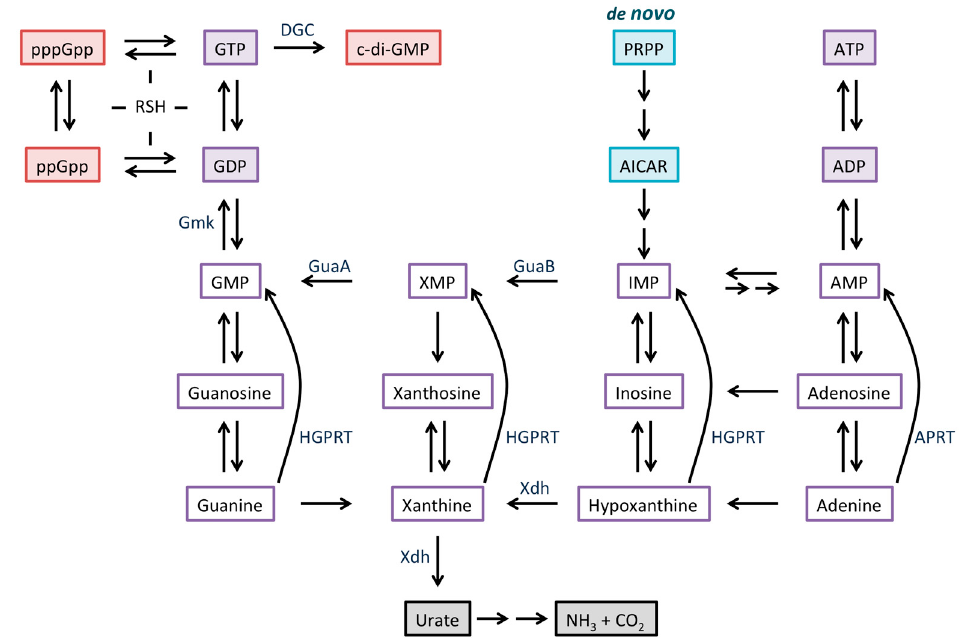
Figure 1. Overview of purine metabolism. The de novo biosynthesis (turquoise) starts with phosphoribosyl pyrophosphate (PRPP) and ends with inosine monophosphate (IMP); the intermediate AICAR (5-aminoimidazole-4-carboxamide ribonucleotide) accumulates in presence of dihydrofolate reductase inhibitors [33] . Intermediates in salvage pathways are outlined in purple. In some species, guanine, xanthine, and hypoxanthine are converted to the corresponding mononucleotides by different enzymes. Xdh can initiate degradation of purines (gray). RelA/SpoT Homolog (RSH) family enzymes are responsible for (p)ppGpp synthesis and hydrolysis, while diguanylate cyclase (DGC) synthesizes c-di-GMP (red).